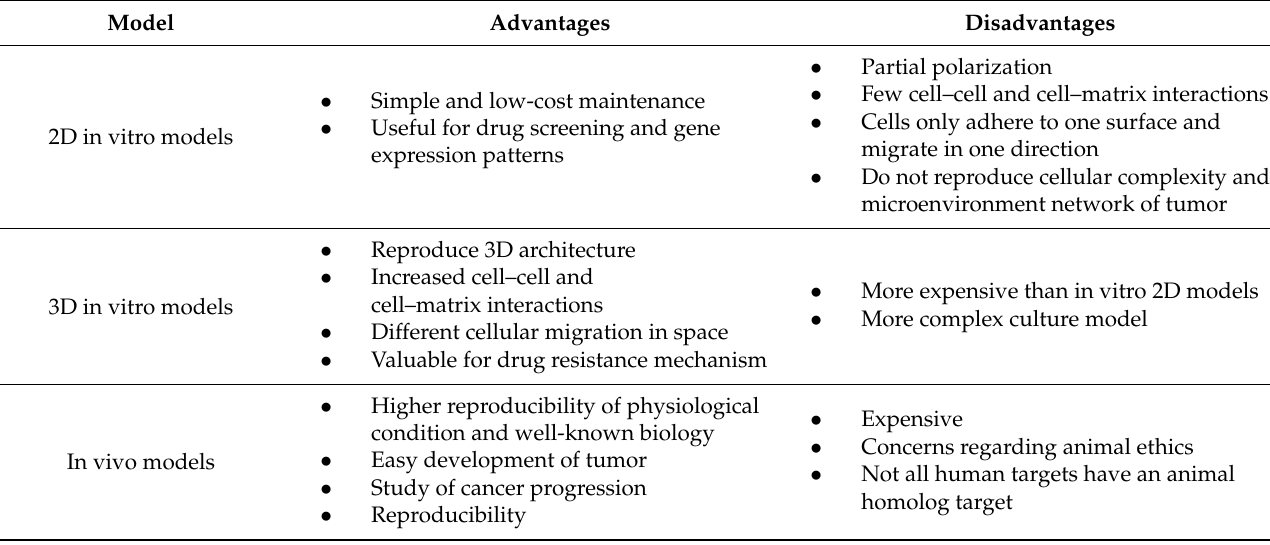
Table 1. Pros and cons of 2D and 3D in vitro and in vivo cancer